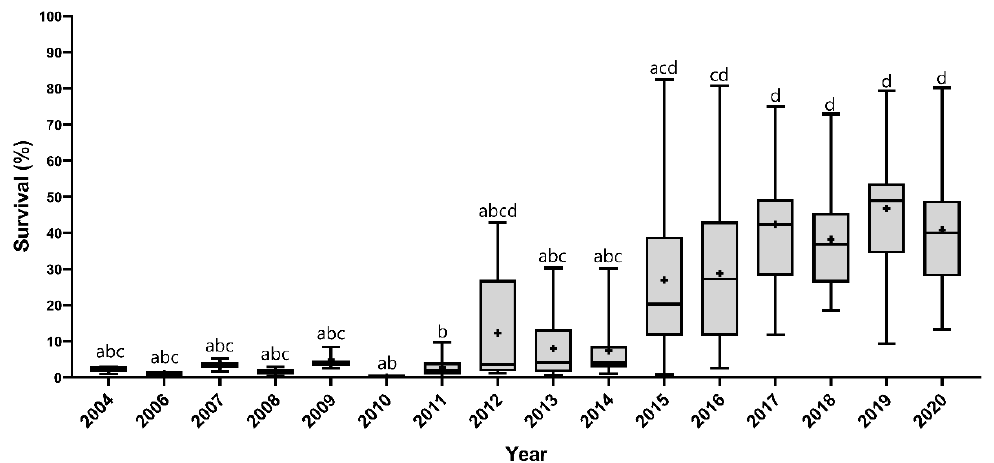
Figure 2. Boxplot showing the increase in survival of Spodoptera frugiperda populations to tefluben- zuron from 2004 to 2020. The (+) sign shows the mean survival at diagnostic concentration of teflubenzuron in populations tested in that year. Different letters show a significative statistical difference between groups (Dunn’s test, p <